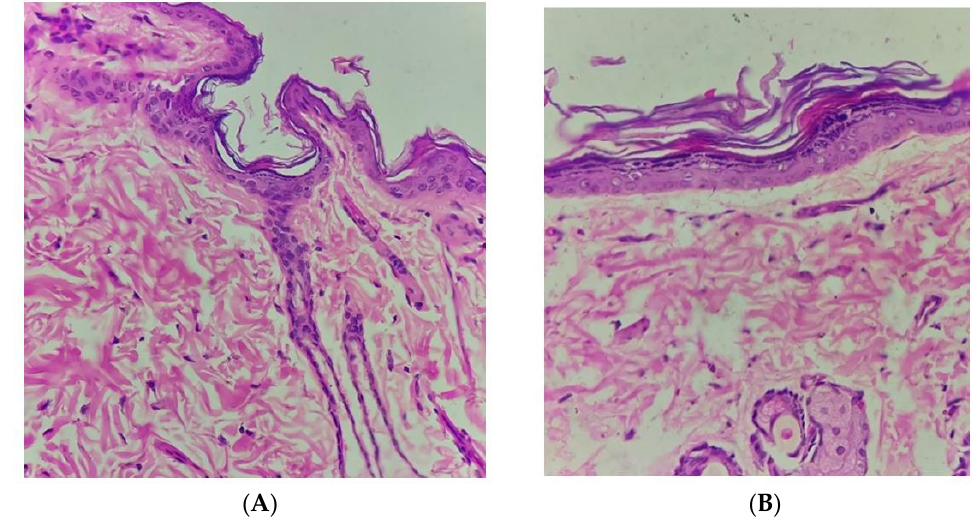
Figure 10. Transverse section of skin of wistar rats following skin irritation study as obtained for the ( A ) control and ( B ) QCT@NG-treated groups.